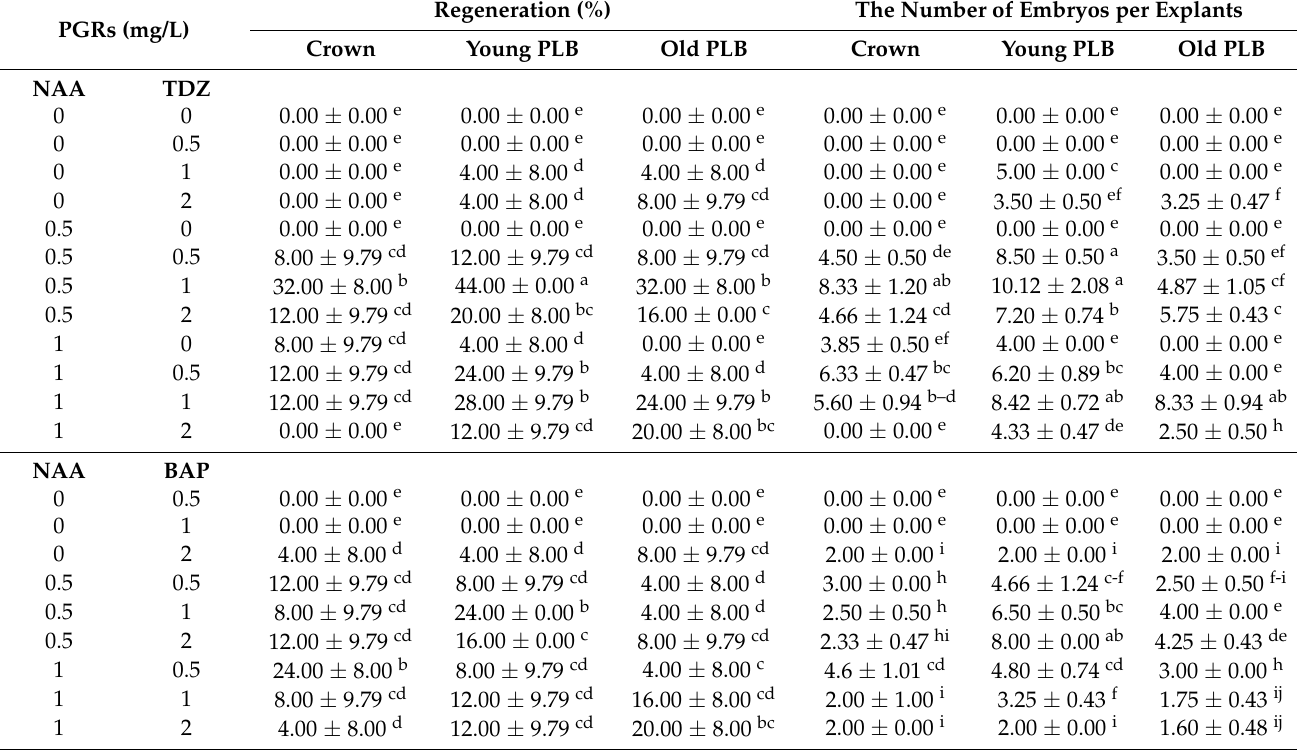
Table 2. The effect of plant growth regulators (PGRs): naphthalene acetic acid (NAA), thidiazuron (TDZ), and benzyl aminopurine (BAP) on the regeneration and number of embryos per explant in the endangered terrestrial orchid species H. affine (Boiss.) Schltr. using different explants (crown, young PLB, and old